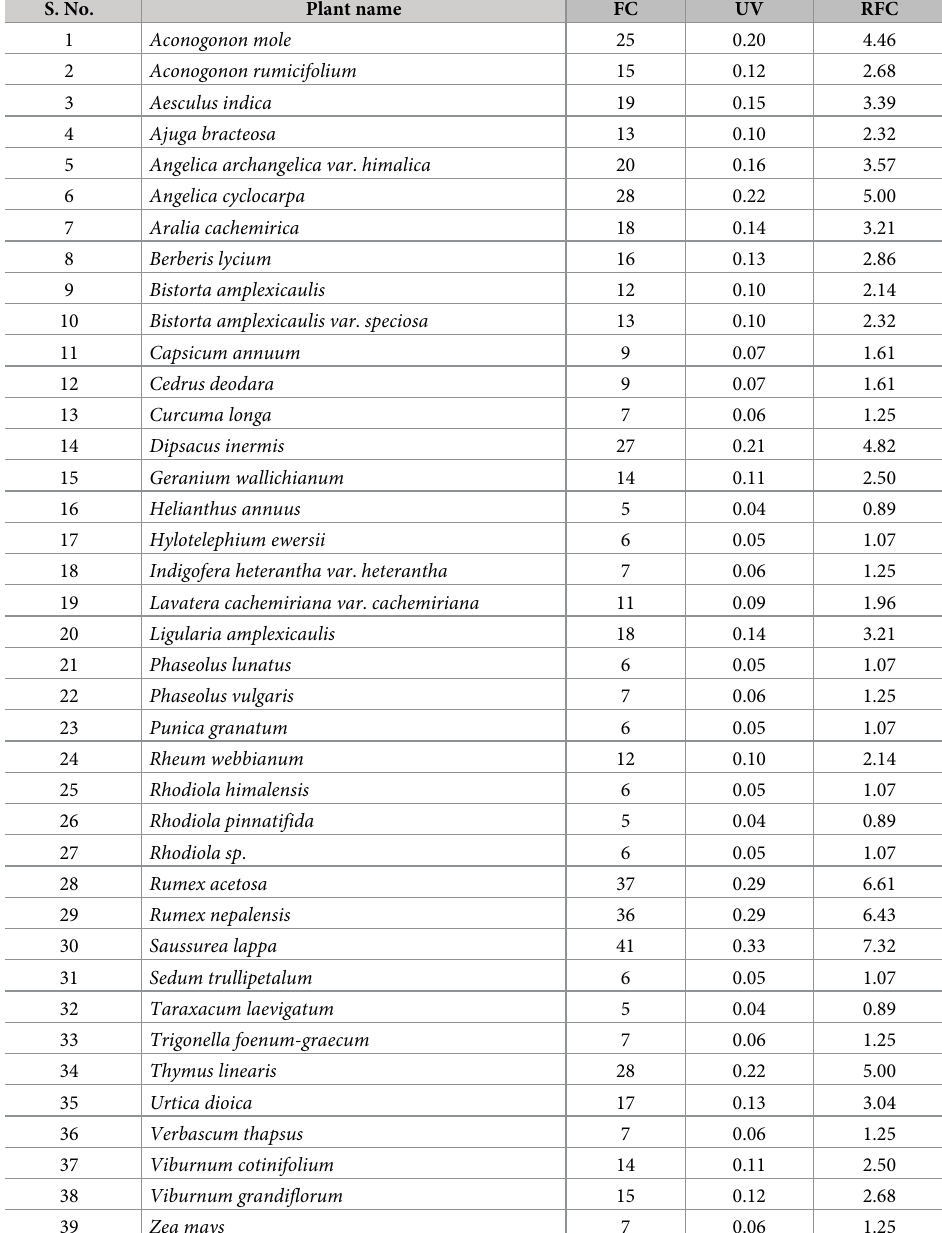
Table 3. Relative frequency of citation and use value of plants of the study